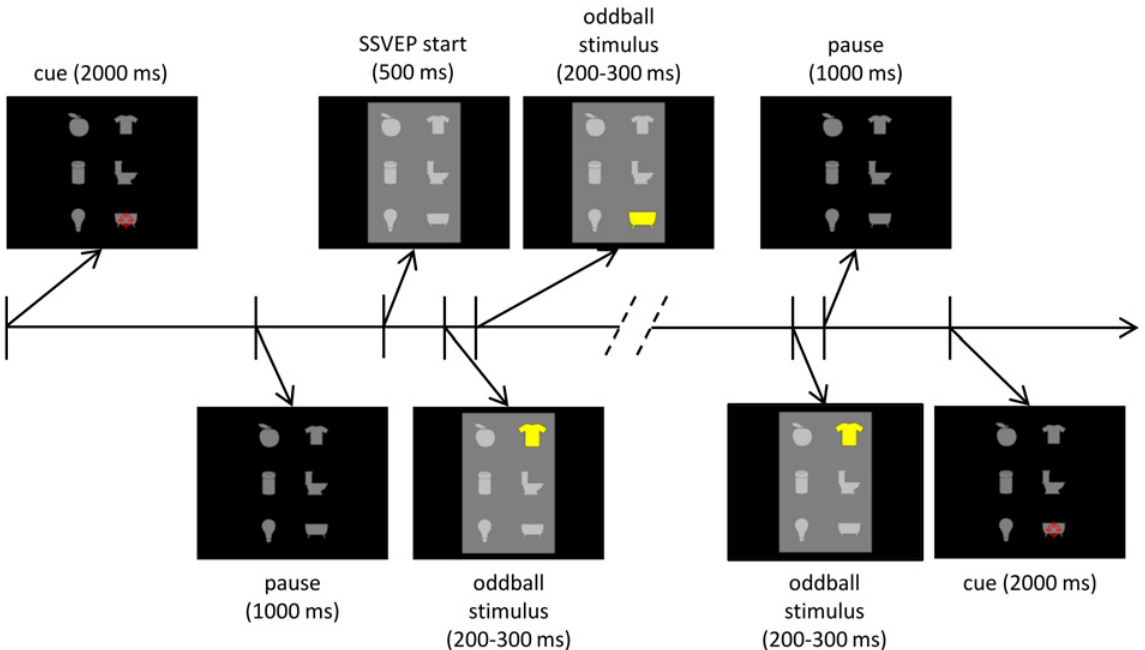
Fig 1. Stimulation cycle for the hybrid condition for the first and second experiment. The stimulation cycle starts with a cue presentation (for 2s), indicating to the participant the target item, followed by a 1s pause during which the cue disappeared and all icons remained gray. A background rectangle then starts to flicker and the oddball stimulation begins 500ms later. The oddball stimulation consists of 10 flashing sequences during which each of the 6 icons is flashed one after another in random order for a duration randomly set between 200 and